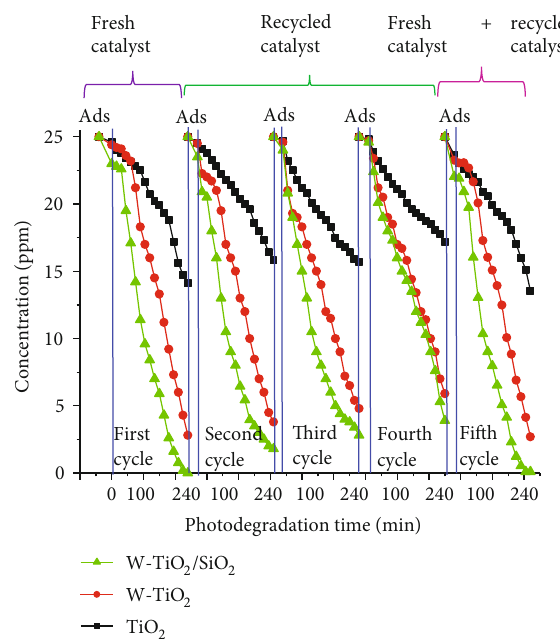
Figure 10: Reusability test of the TiO